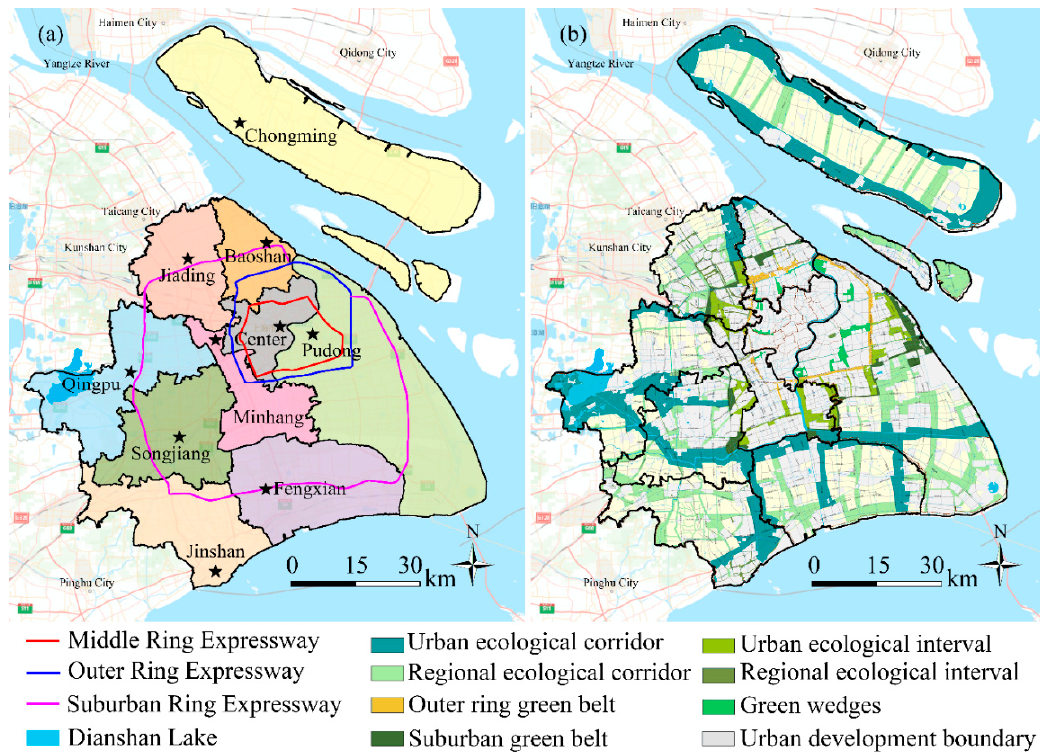
Figure 1. The study area of Shanghai: ( a ) The map of administrative divisions and expressways of Shanghai; and ( b ) Shanghai’s Ecological Network Planning Map.